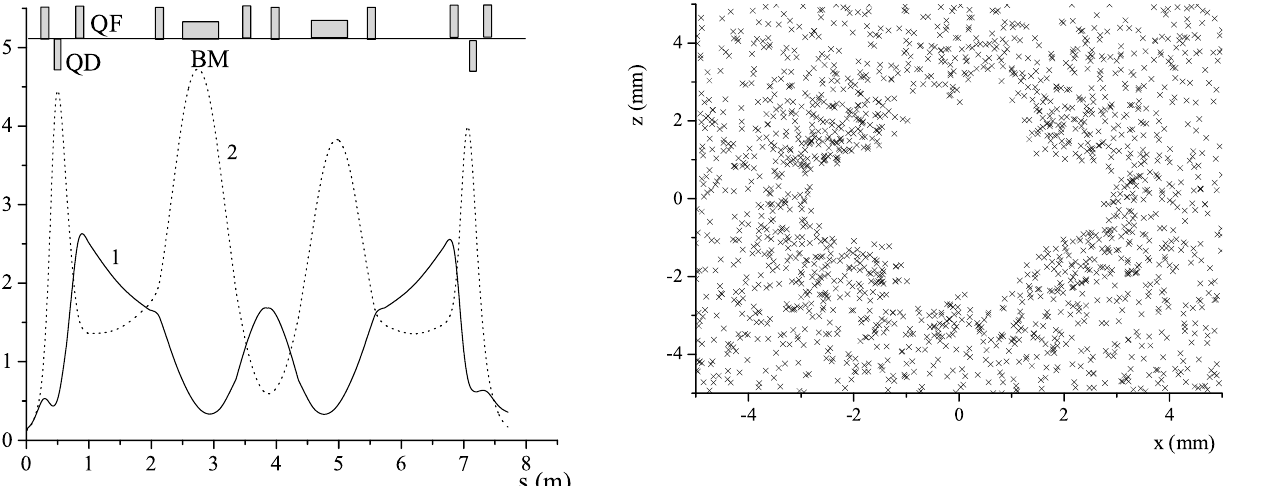
FIG. 4. Dynamic aperture of ring at IP azimuth at initial (cid:1) 3 : 5% . Number of particles are momentum deviation (cid:8) ini (cid:3) 1 (cid:4) and vertical (cid:29) (cid:3) 2 (cid:4) amplitude func- .FIG. 2. Horizontal (cid:29) x z 3000, turns number 50 000. Lost particles are marked by (cid:14) tions over half of ring lattice. Fig. 3. We can obtain zero linear dispersion either over both long straight sections or over one of them by controlling of the strength of separated quadrupole in the ring arc. In the first case we obtain the operation mode with a large linear (cid:1) 0 : 078 (BM mode). In momentum compaction factor (cid:12) 1 the second case dispersion function (cid:15) is negative on orbit 1 within one bending of the arc, and we obtain operation mode with decreased momentum compaction factor (LM mode). Dispersion function (cid:15) in Fig. 3 corresponds to 1 (cid:1) 0 : 019 . The maximal value of the dispersion function (cid:12) 1 (cid:2) 1 : 2 m, its maximal value on long straight on arc (cid:15) 1max section is equal to 0.3 m.